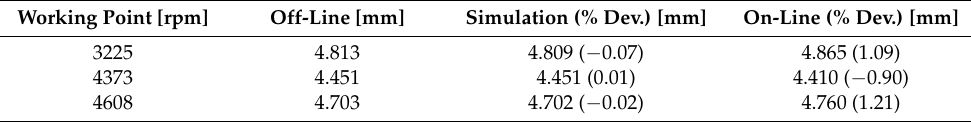
Table 2. Minimum TC [mm] obtained with the one-turn-filtered set of signals.